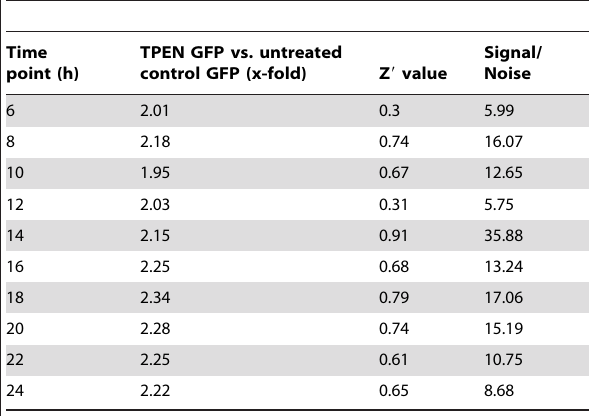
Table 1. Summary of robustness criteria of the promoter- reporter assay.